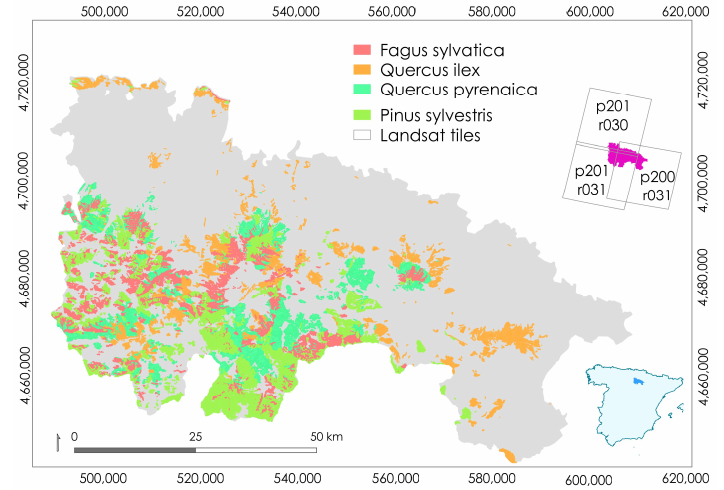
Figure 1. La Rioja study area and distribution of the main forest species based on the Spanish National Forest Map. ETRS89 / UTM zone 30N (N-E) (EPSG: 3042). The blue polygon in the lower right corner depicts the location of the study area in north central